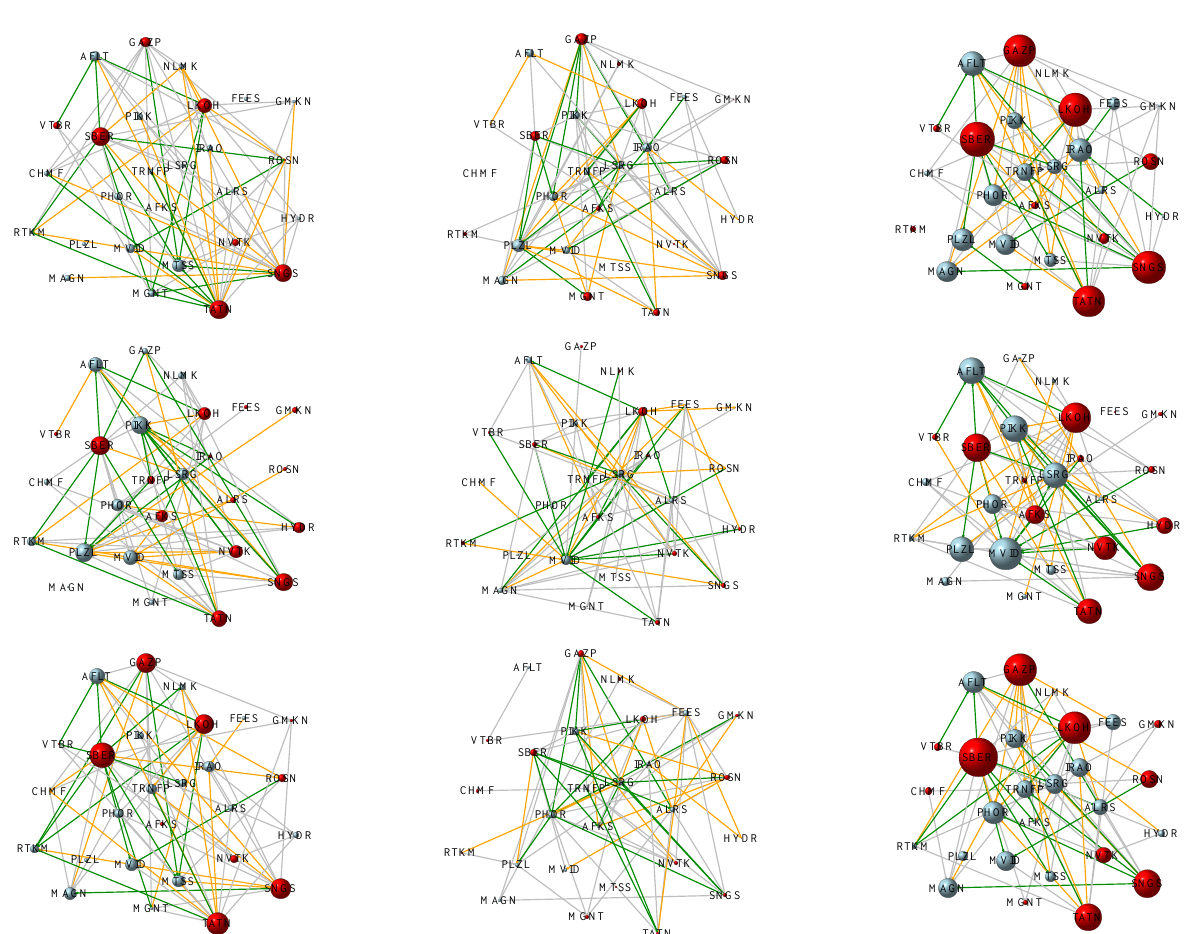
Figure 11. Frequency decomposition of pairwise volatility spillovers networks (window: from 1 March 2015 to 1 March